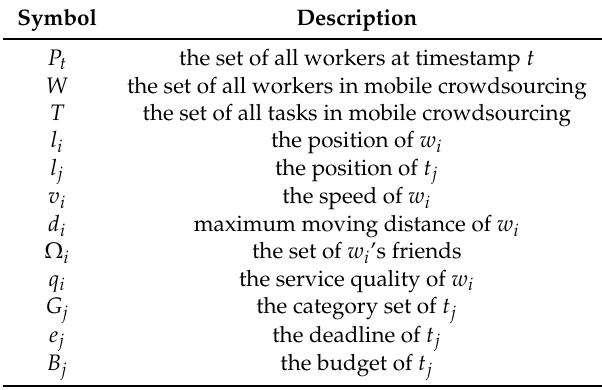
Table 2. Symbols and